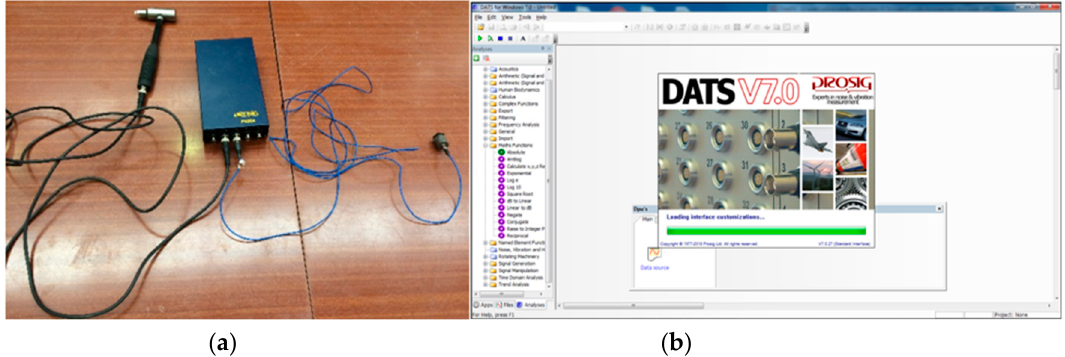
Figure 4. ( a ) Large-scale ballast bed. ( b ) Small-scale ballast bed.